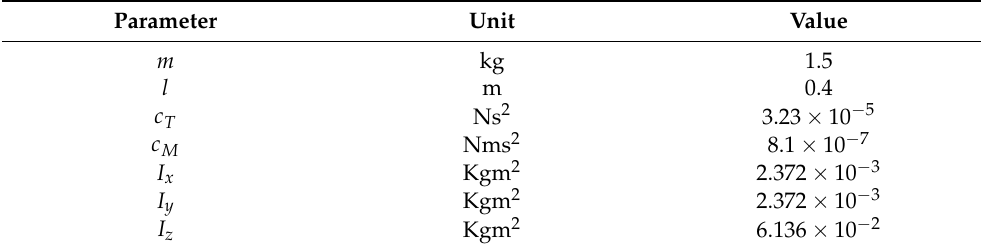
Table 1. The parameters of quadrotor UAV. Parameter